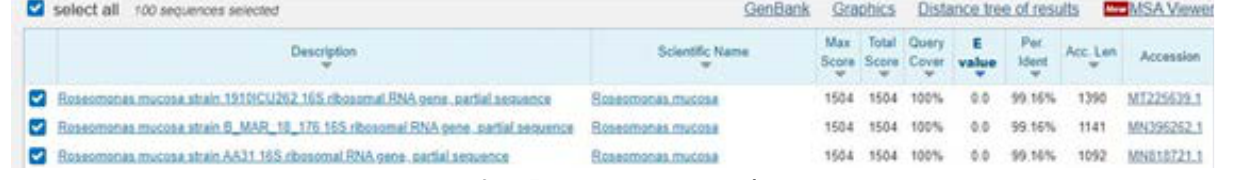
fIgURE 7 – Genetic Sequencing: Gene